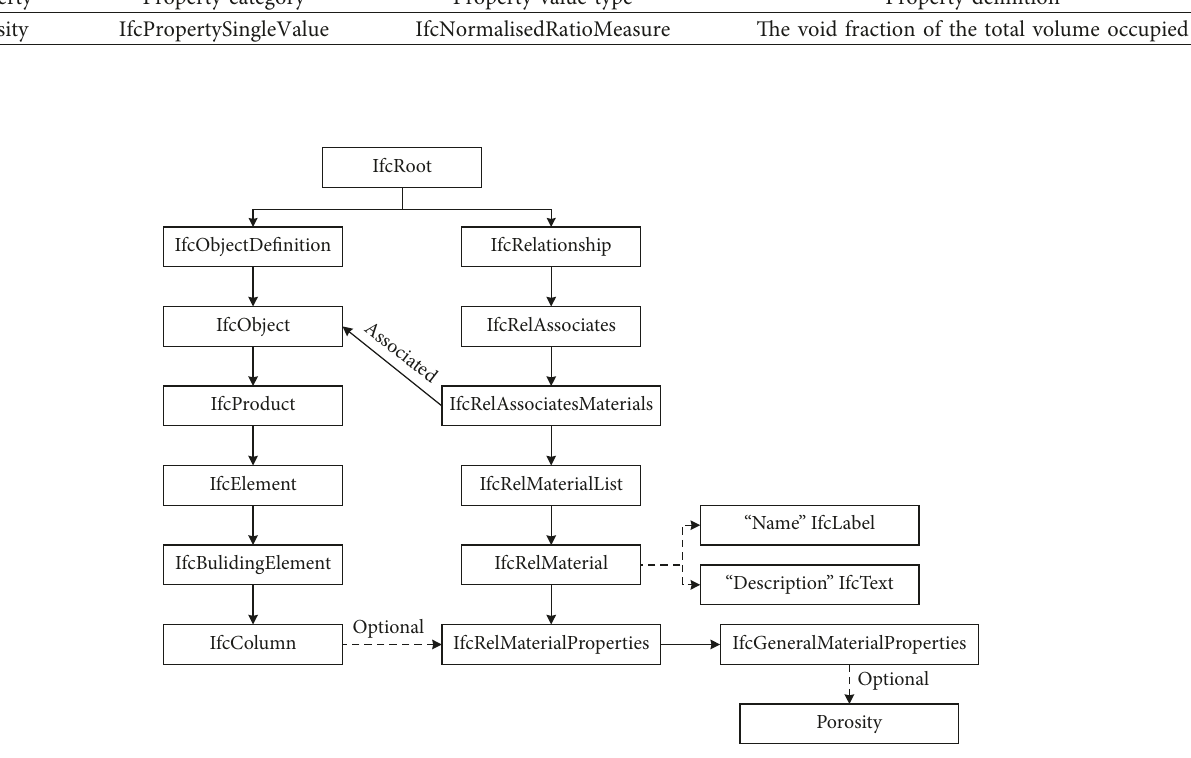
Figure 5: The IFC expression of raw material consumption.